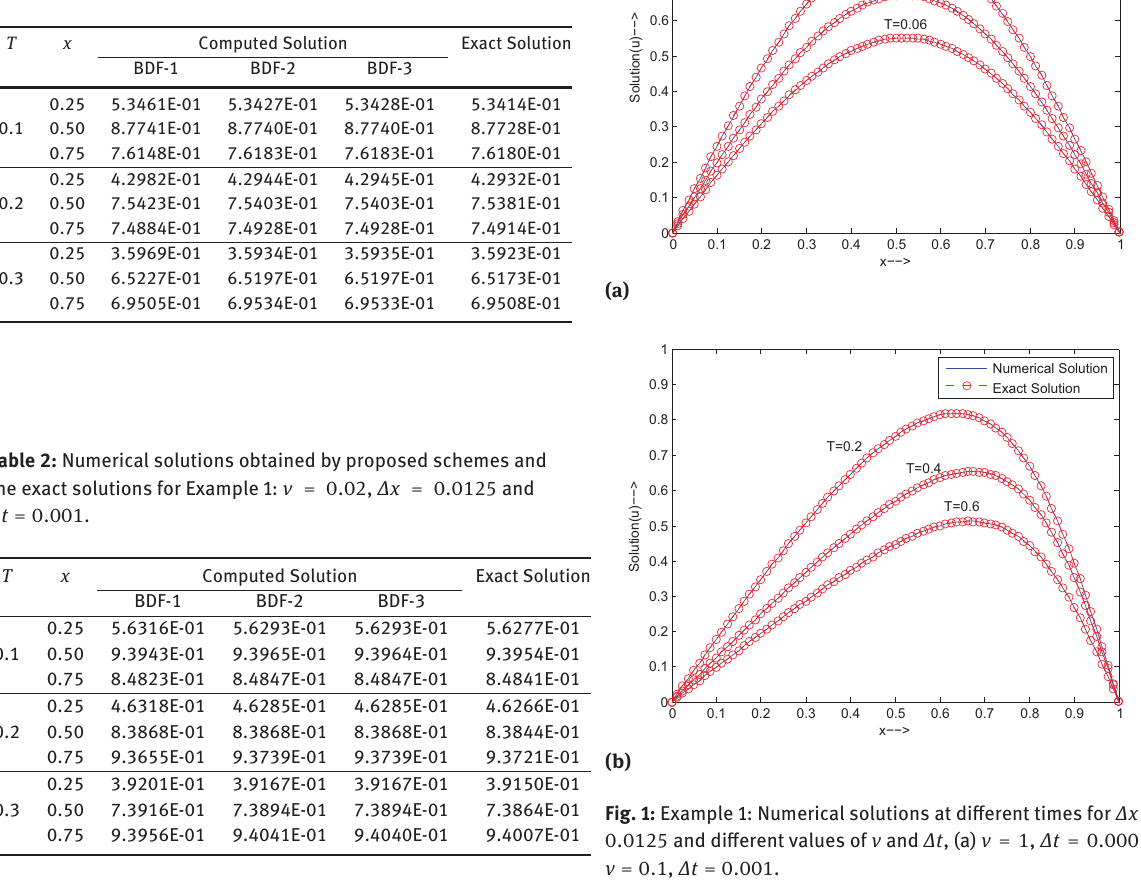
Table 1: Numerical solutions obtained by proposed schemes and the exact solutions for Example 1: ν = 0.1 , Δx = 0.0125 and Δt = 0.001 .